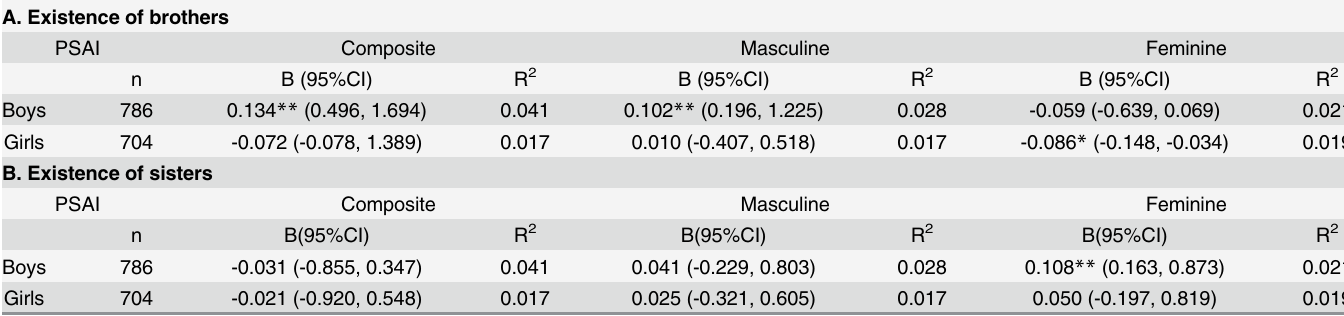
Table 6. Analysis of the relationship between PSAI and the existence of brothers or sisters in a multiple linear regression